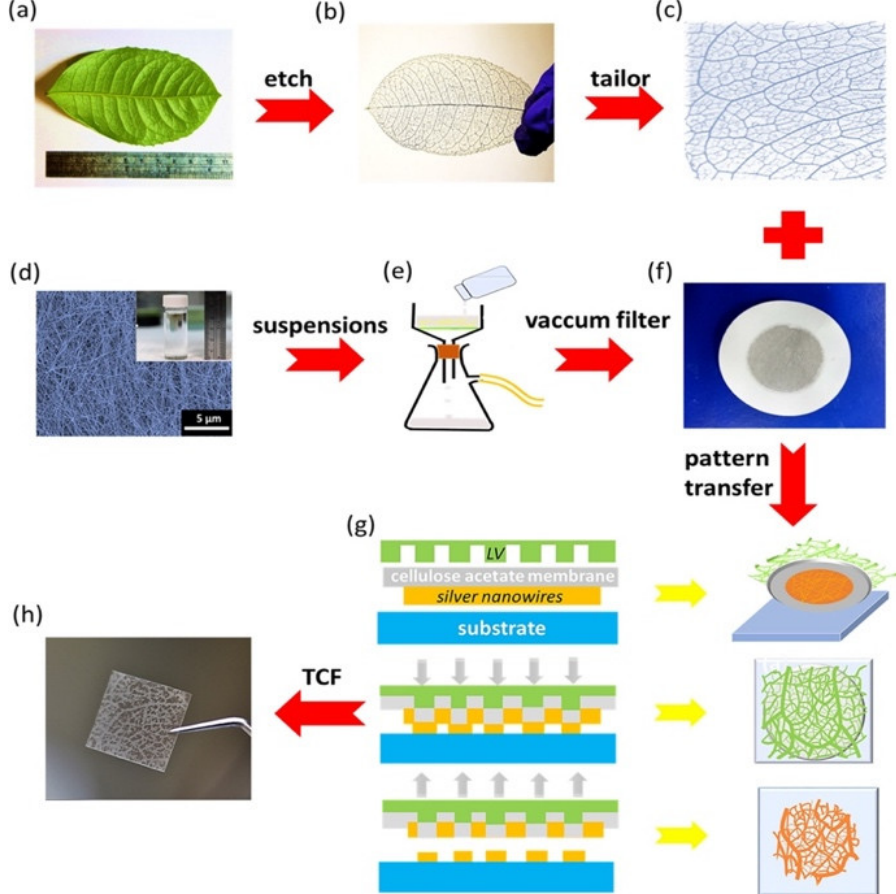
Figure 5. Network of LV-like Ag nanowires of the hybrid nanogenerator fabricated by Sun et al. [104]. Images of ( a ) the structure of a ramified leaf used as a mold to fabricate the patterns of TEs. ( b ) The skeleton of the leaf venation and ( c ) LV network were prepared in a square shape to be used as a mold. ( d ) SEM image of Ag nanowires. These nanowires were synthesized in a small bottle. ( e ) Schematic of vacuum filtration of the Ag nanowires. ( f ) Image of Ag nanowires film filtered using a cellulose acetate membrane. ( g ) Schematic of a modified dry transfer printing technique to fabricate the LV-like Ag nanowires network. ( h ) Image of the LV-like Ag network on a PDMS substrate (size of 3.5 cm × 3 cm). Reprinted with permission from [105]. Copyright ©2018, Elsevier Ltd. In 2019, Li et al. [106] reported a hybrid nanogenerator based on cellulose nanofibril (CNF) as a triboelectric layer and bacterial cellulose (BC) with nanoparticles of BaTiO 3 and a multi-walled carbon nanotube (MWCNT) as piezoelectric layer. The CNF fibers were treated by employing a mixed solution of HNO 3 and H 2 SO 4 . In addition, a -NO 3 group is applied to enhance the electronegativity of the CNF fibers. This hybrid nanogenerator is formed by two composite layers. The top arched layer acts as PENG, using a functionalized BC paper with two Ni electrode films. The PENG has an arched shape to improve the strength of the effective strain applied to the bacterial cellulose film. The bottom